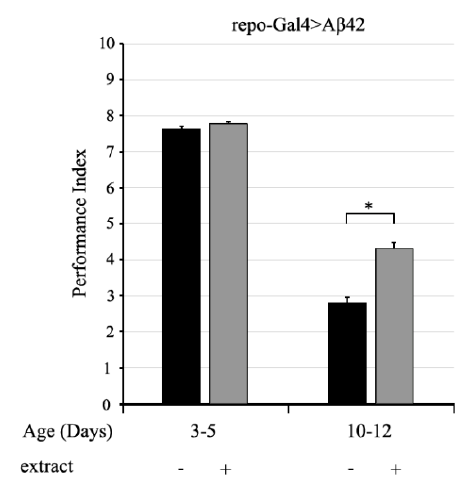
Figure 5. Alzheimer’s disease (AD) flies expressing A β 1–42 in glial cells using the repo-Gal4 driver were allowed to feed on the diet supplemented with EtOAc extract (40 µ L/mL in standard sugar-yeast medium) for the entire developmental period and then assayed for climbing activity at 3–5 and 10–12 days. Climbing abilities are presented as the average performance index (PI) ± SEM. * p < 0.05.